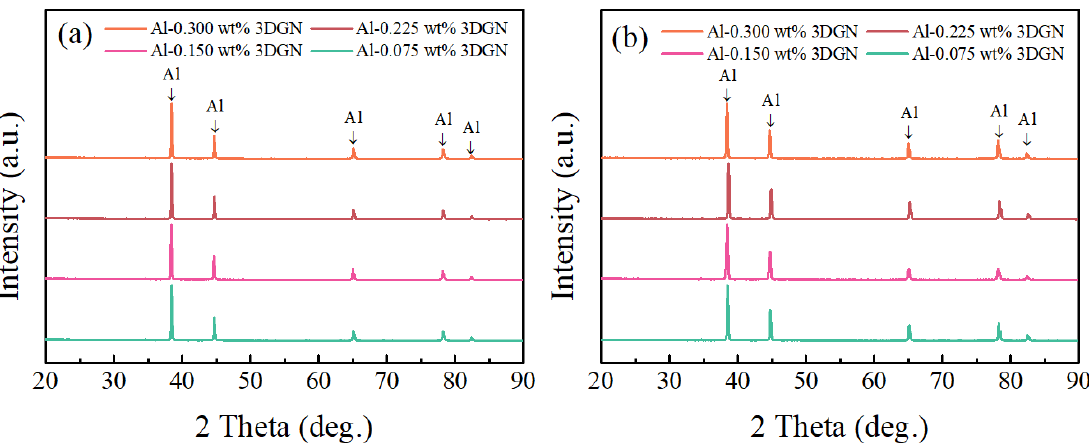
Figure 3. XRD patterns of fabricated ( a ) 3DGN/Al composite powders and ( b ) sintered 3DGN/Al composites.